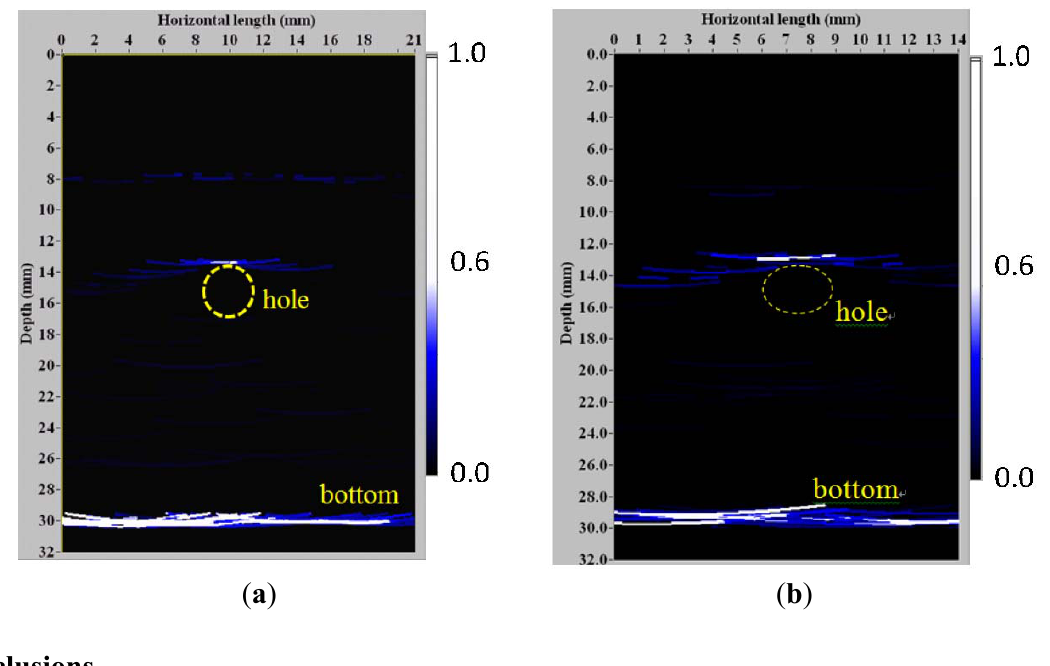
Figure 7. TFM images of ( a ) 8-elements FUT array (element size: 10 mm × 2 mm, gap: 1 mm) and ( b ) 7-elements FUT array (element size: 9 mm ×2 mm, gap: 0.5 mm) inspecting an Al alloy block of 30 mm thickness with a SDH of φ 3 mm at the middle at 150 °C. Dashed circle: